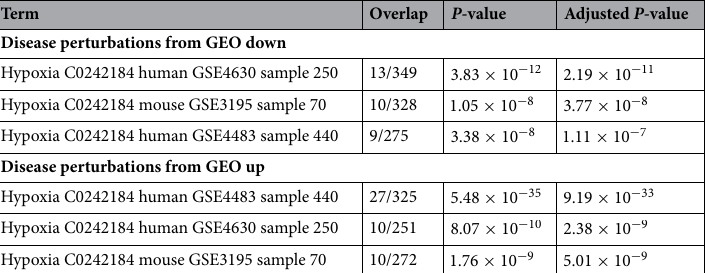
Table 2. “Disease Perturbations from GEO down/up” category of Enrichr for 52 genes selected by applying PCA-based unsupervised FE to gene expression profiles. Six hypoxia experiments with adjusted P -values less than 0.05 are